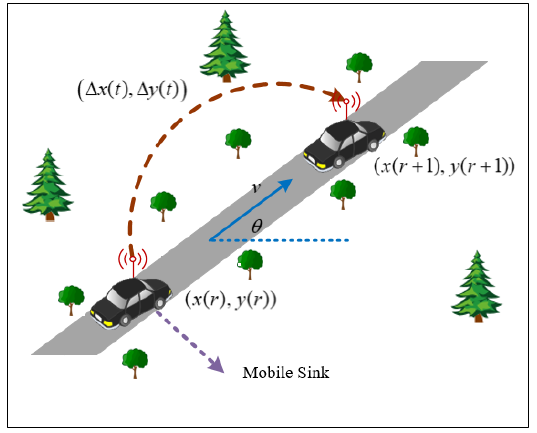
Figure 2. Motion